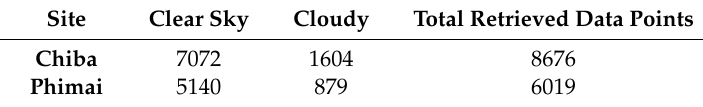
Table 5. The number of clear sky and cloudy data points for Chiba and Phimai sites retrieved from the sky radiometer observations. The data are shown for the observation period from January 2019 to September